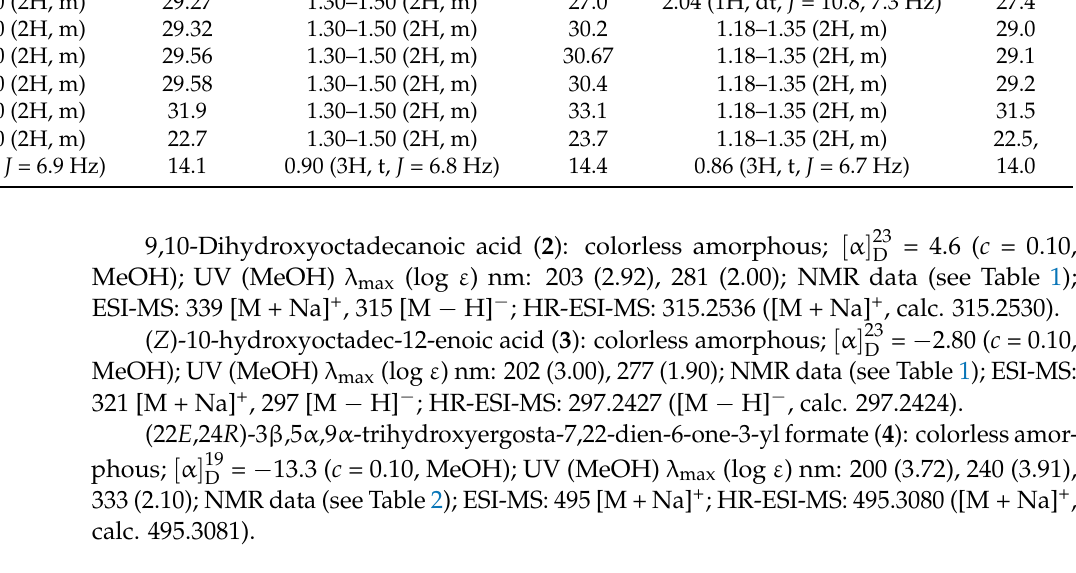
Table 2. The NMR data of compounds 4 and 5